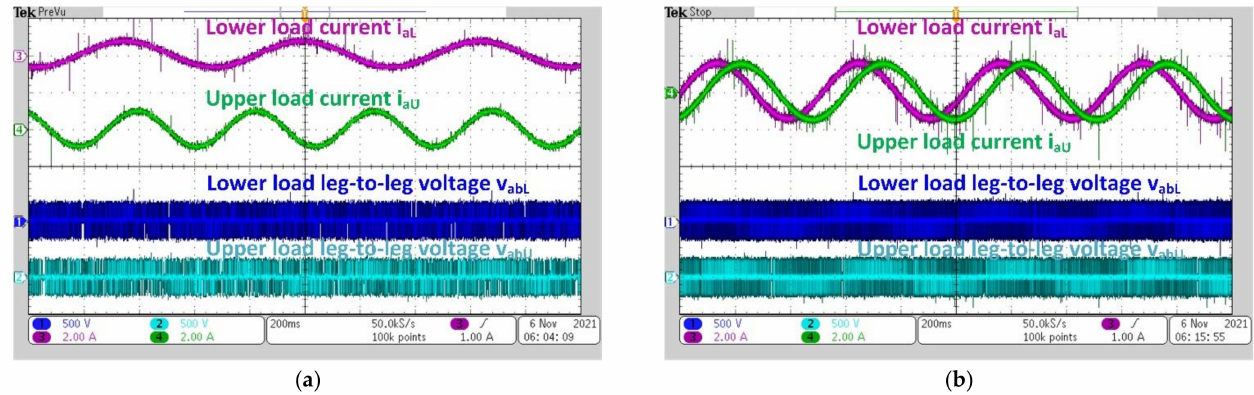
Figure 7. Stator currents ( i aU and i aL ) and leg-to-leg voltages ( v abU and v abL ) for both output stages. Scope channel 1: Leg-to-leg voltage v abL of the lower stage. Scope channel 2: Leg-to-leg voltage v abU of the upper stage. Scope channel 3: Phase current, i aL , of the lower stage. Scope channel 4: Phase current, i aU , of the upper stage. The current scale is 2 A per division. The voltage scale is 500 V per division. ( a ) stator current waveforms at different frequencies for both outputs; ( b ) stator current waveforms for the symmetrical six-phase reference with a phase displacement of 60 ◦